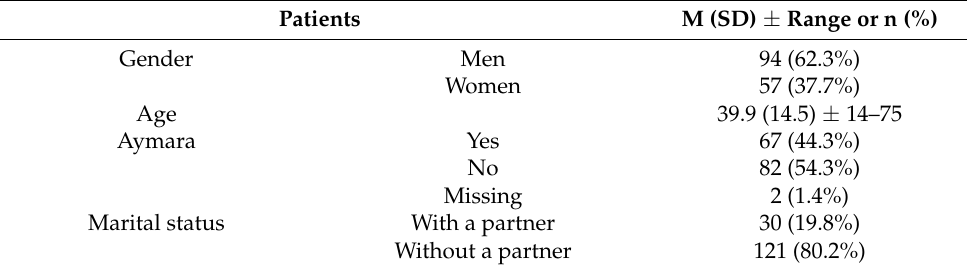
Table 1. Sociodemographic